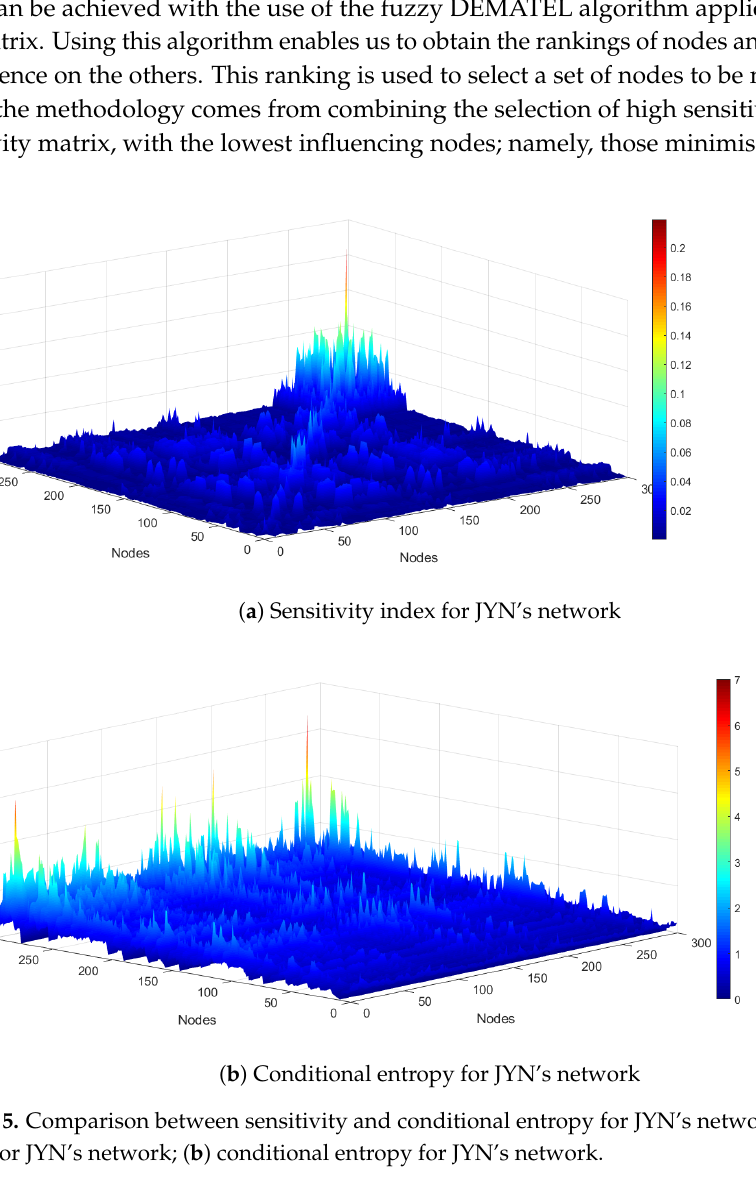
Figure 5. Comparison between sensitivity and conditional entropy for JYN’s network. ( a ) Sensitivity index for JYN’s network; ( b ) conditional entropy for JYN’s